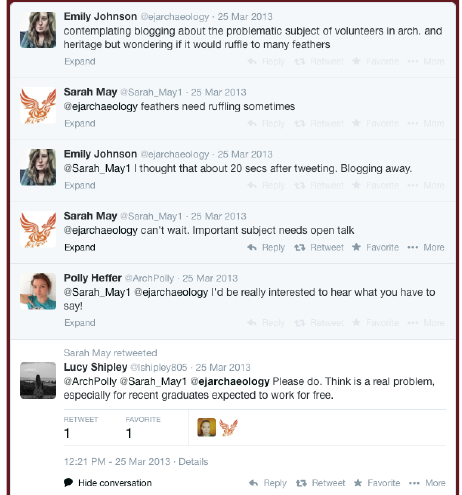
Figure 1: The tweet that initiated the #Free Archaeology